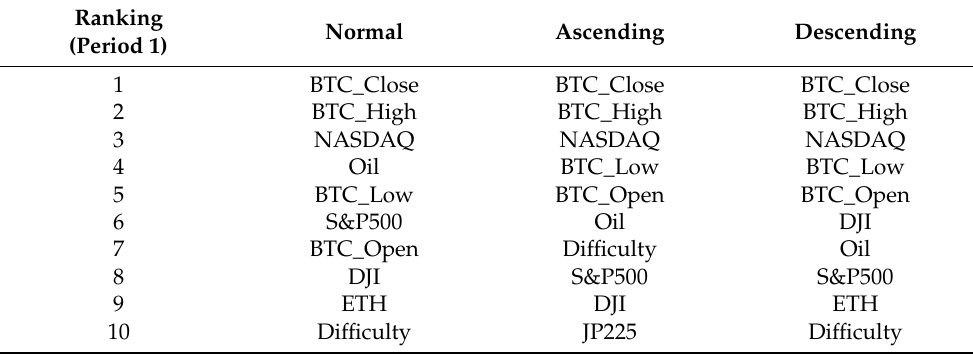
Table 5. Summary of explanatory variables importance of Period 1.